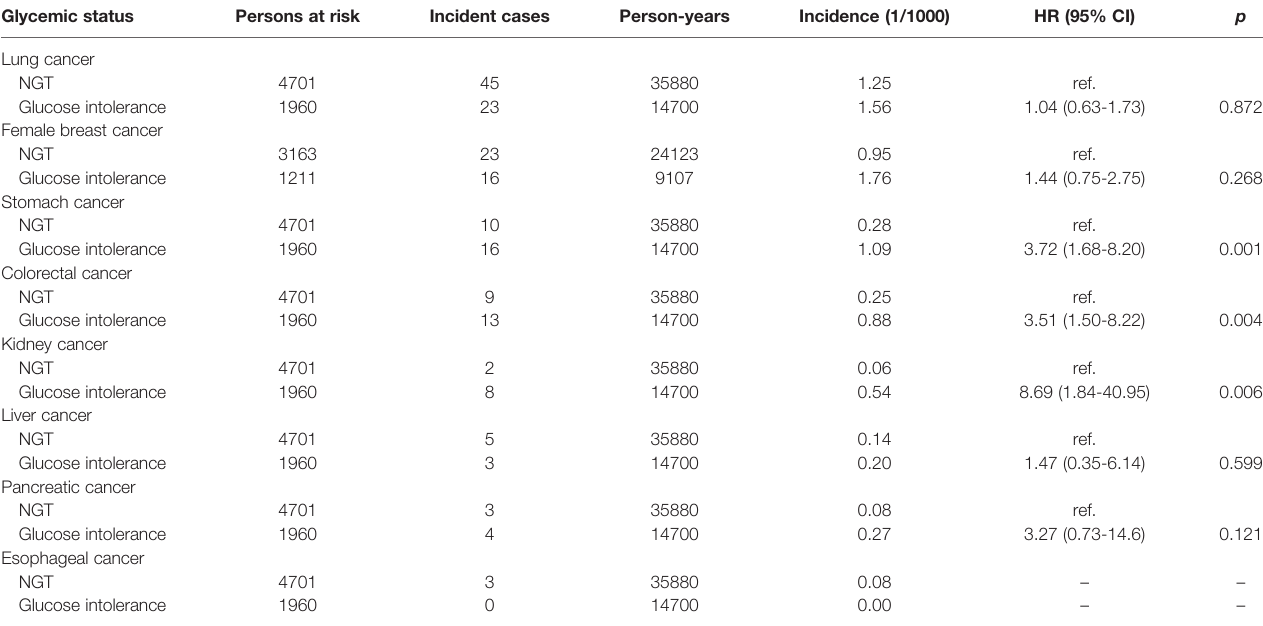
TABLE 4 | The Cox regression analysis of the association of site-speci fi c cancer with the baseline glycemic status in the adults < 65 years, adjusted for age and sex. Glycemic status Persons at